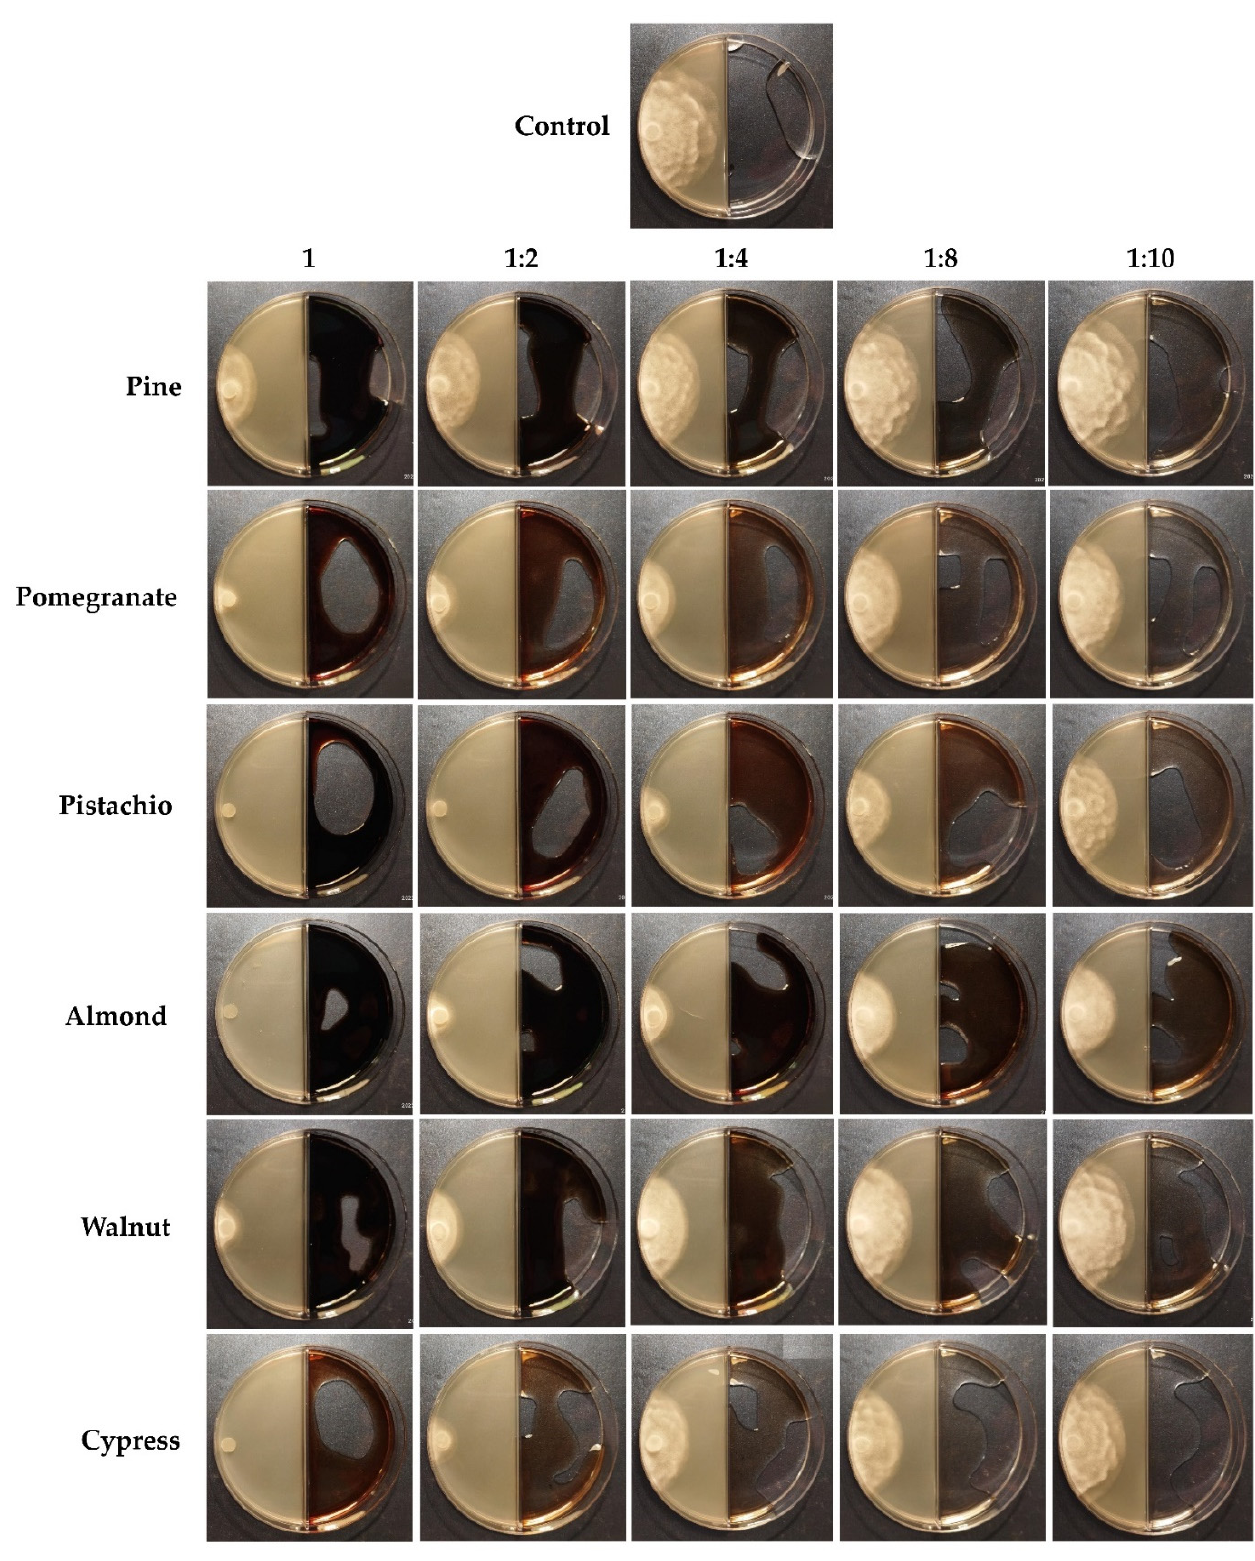
Figure 3. In vitro assay of six plant species wood vinegar using 5 dilutions against mycelial growth of Phytopythium sp. (ON409943).